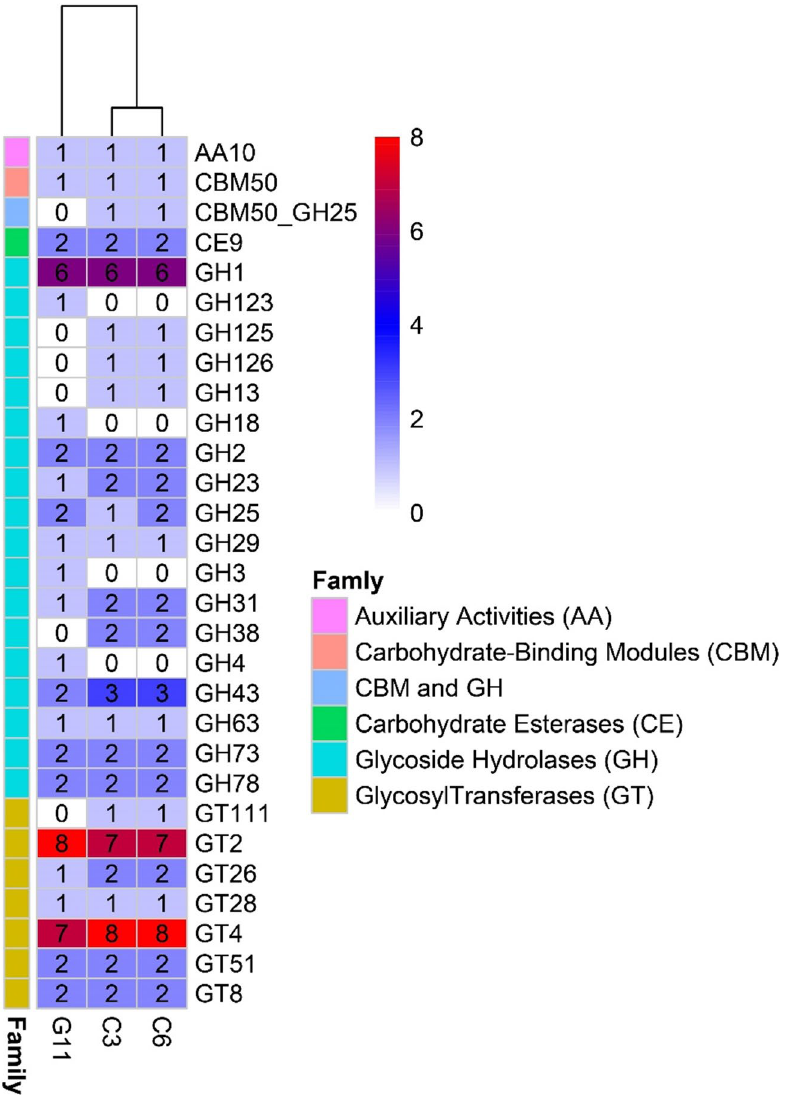
Figure 8. CAZymes present in C3, C6 and G11 were represented in a heatmap. Auxiliary Activities (AAs) represent redox enzymes that act in conjunction with CAZymes; Carbohydrate-Binding Modules (CBMs) represent adhesion to carbohydrates; Carbohydrate Esterases (CEs) represent hydrolysis of carbohydrate esters; Glycoside Hydrolases (GHs) represent hydrolysis and/or rearrangement of glycosidic bonds; and GlycosylTransferases (GTs) represent formation of glycosidic